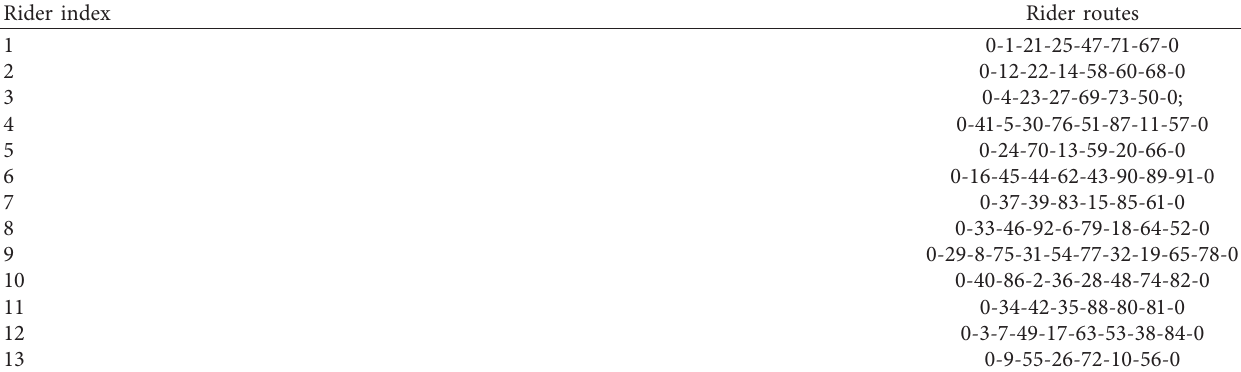
Table 5: Optimization of rider